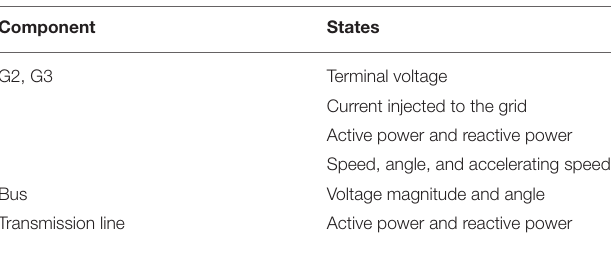
TABLE 1 | Key variable candidates.